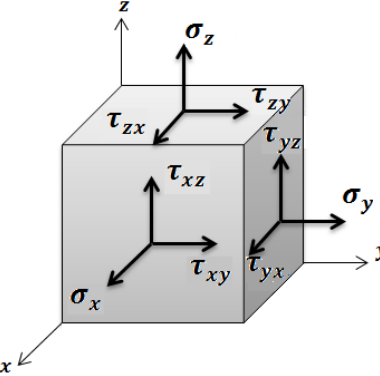
Figure 8. The multi-axial stress state.